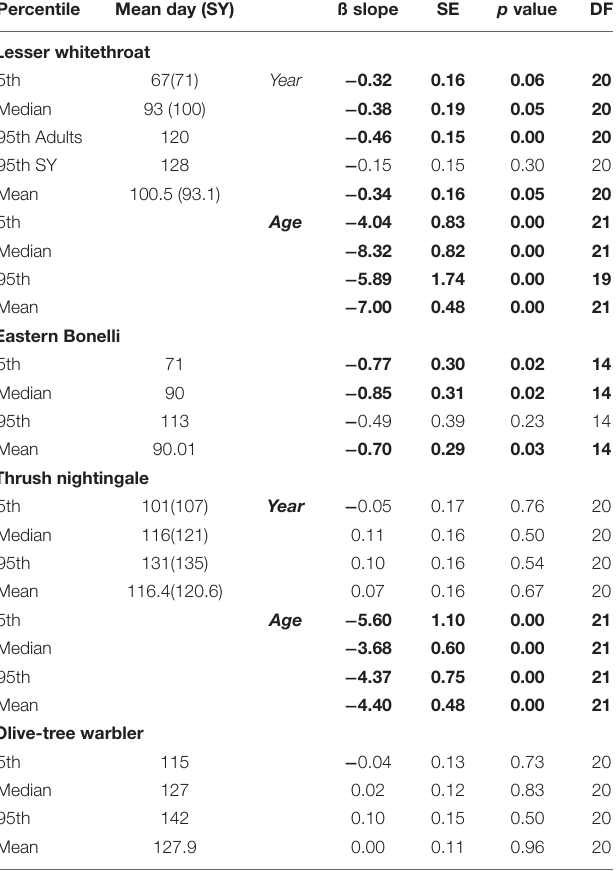
TABLE 1 | Summary of the changes in arrival timing (days per year) of the first 5th percentile, median, 95th percentile and mean arrival of the four studied species to stopover site in Israel, estimated by generalized linear mixed effect models, and the difference between age groups (Adults and second year; SY) where age could be identified.